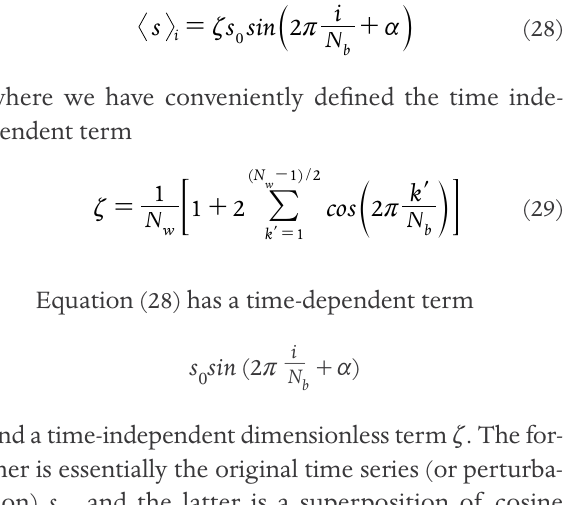
and the pulsation period N w